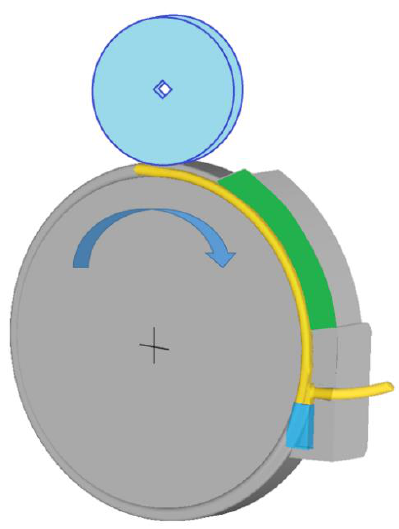
Figure 1. Schematic drawn of the ECAP – Conform process.